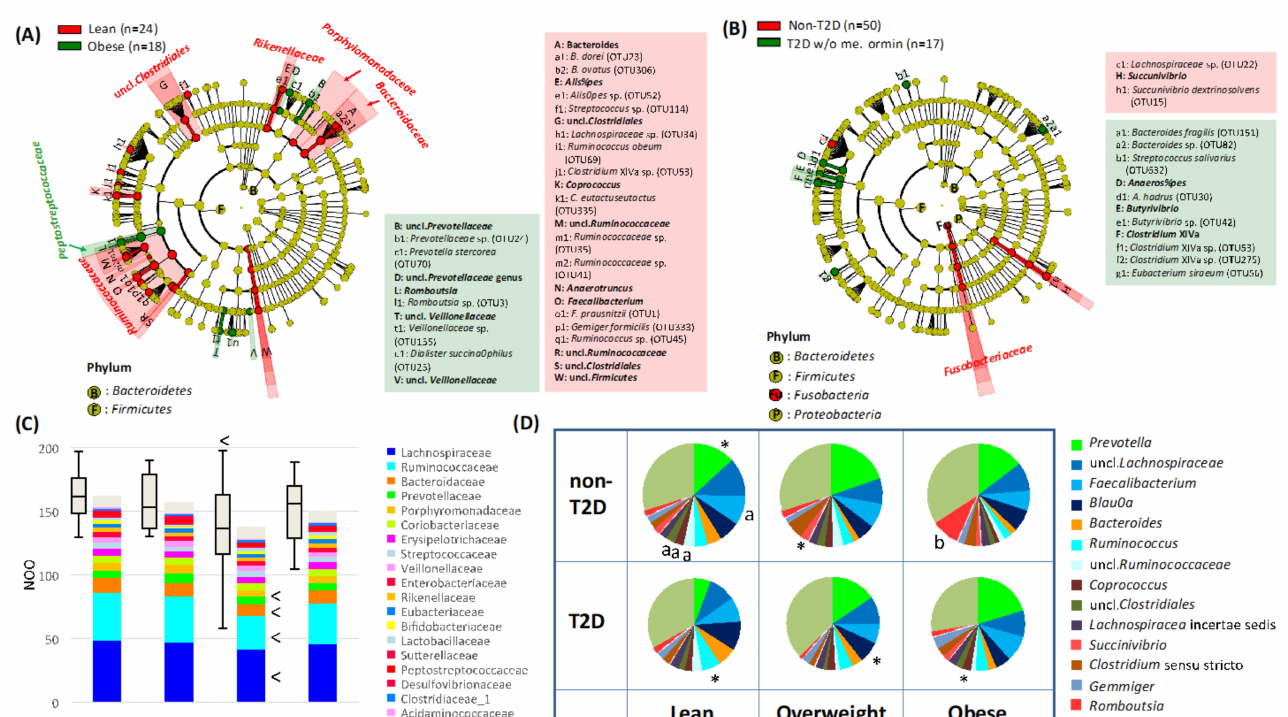
Figure 2. Fecal microbiome features associated with obesity and T2D. ( A ) LEfSe showing taxa distinguishing non-T2D obese subjects as compared to non-T2D lean subjects. The Lefse analysis was performed using bacterial composition data of fecal samples from phylum to OTU levels, in which species were represented by OTUs (Supplementary Table S4). The LDA scores were calculated by using the Wilcoxon rank-sum test and the taxonomic groups showing LDA scores higher than 3.0 with p < 0.05 were highlighted by the indicated color on the cladogram. ( B ) LEfSe showing taxa distinguishing T2D lean subjects as compared to non-T2D lean subjects. The LEfSe analysis were performed by the same methods as ( A ). ( C ) Comparison of the number of OTUs observed in each sample among non-T2D lean, non-T2D overweight, non-T2D obese, and T2D subjects. The number of observed OTUs (NOO) was estimated for each family and stacked in the bar graph accompanied with box plot showing the distribution of total NOO. Welch t-test was performed to examine the statistical difference as compared to the non-T2D lean group and total NOO and the families with statistically lower NOO were marked by less-than a sign. ( D ) Cross comparison of genus composition among lean, overweight, and obese subgroups, and between T2D and non-T2D subgroups. Asterisk represents results that are statistically higher in the indicated group in the comparison between non-T2D and T2D subgroups of the same BMI group ( p < 0.05 in Wilcoxon rank-sum test). Letters, “a” and “b”, represent those statistically higher in the lean subgroup compared to the obese subgroup and vice versa within the non-T2D group ( p < 0.05 in pairwise Wilcoxon rank-sum test with Bonferroni adjustment among lean, overweight, and obese